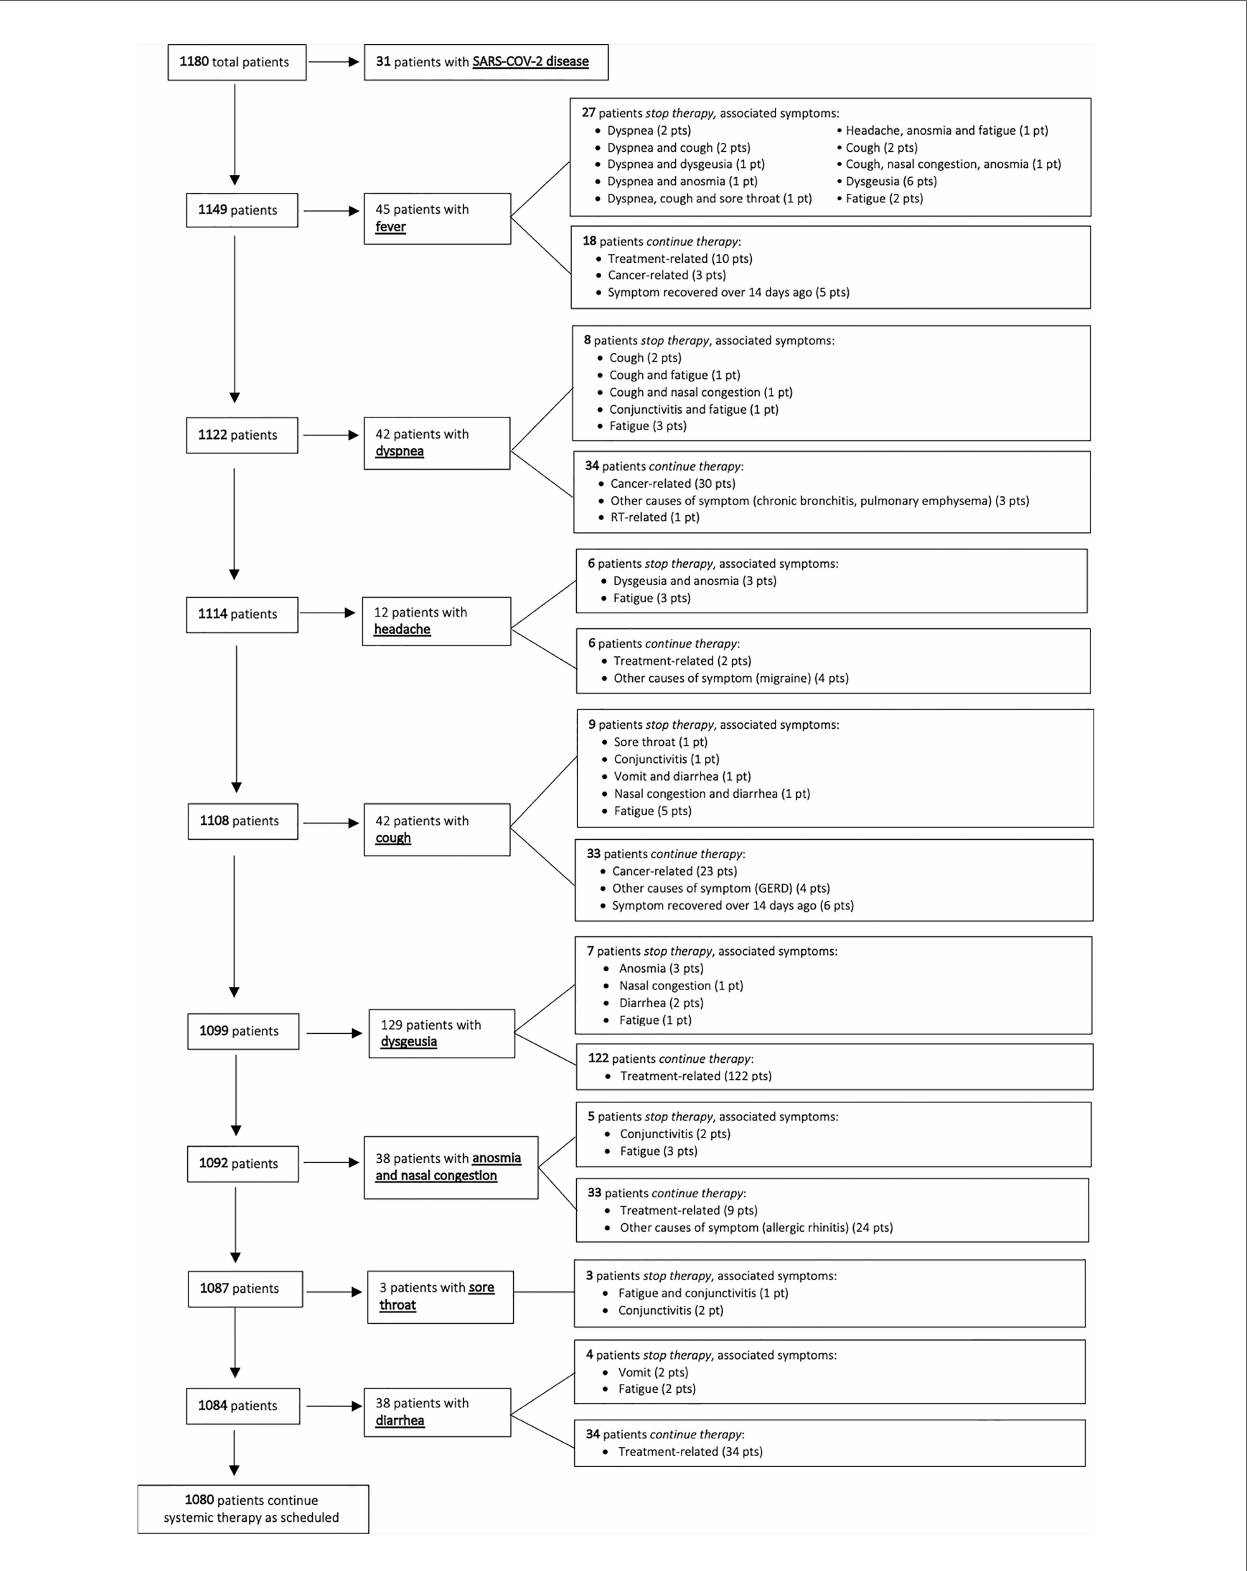
FIGURE 2 | Flowchart of triage questions selecting patients eligible for